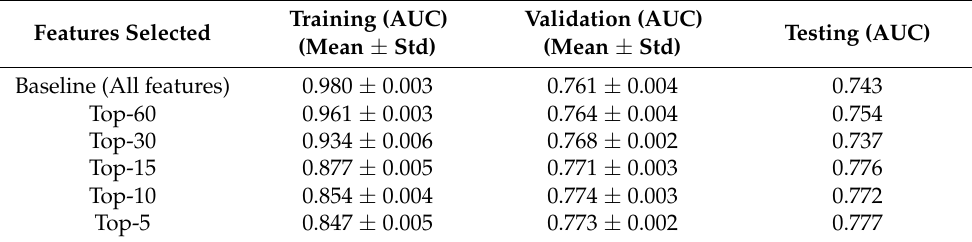
Table 9. The performance with reduced feature sets for PDA vs. healthy. Features